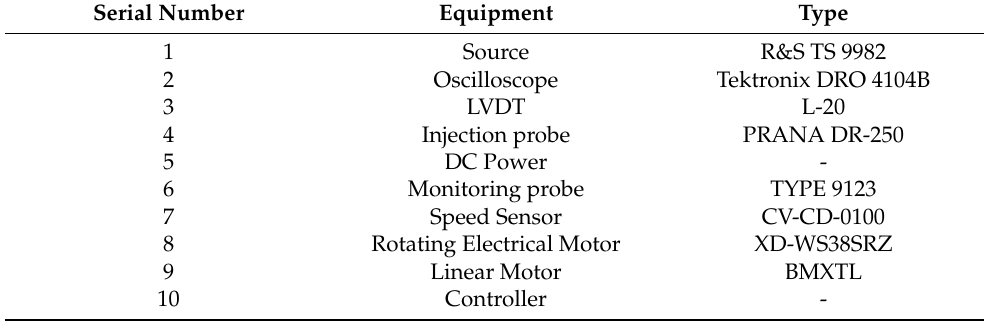
Figure 6. Bulk current injection test layout.